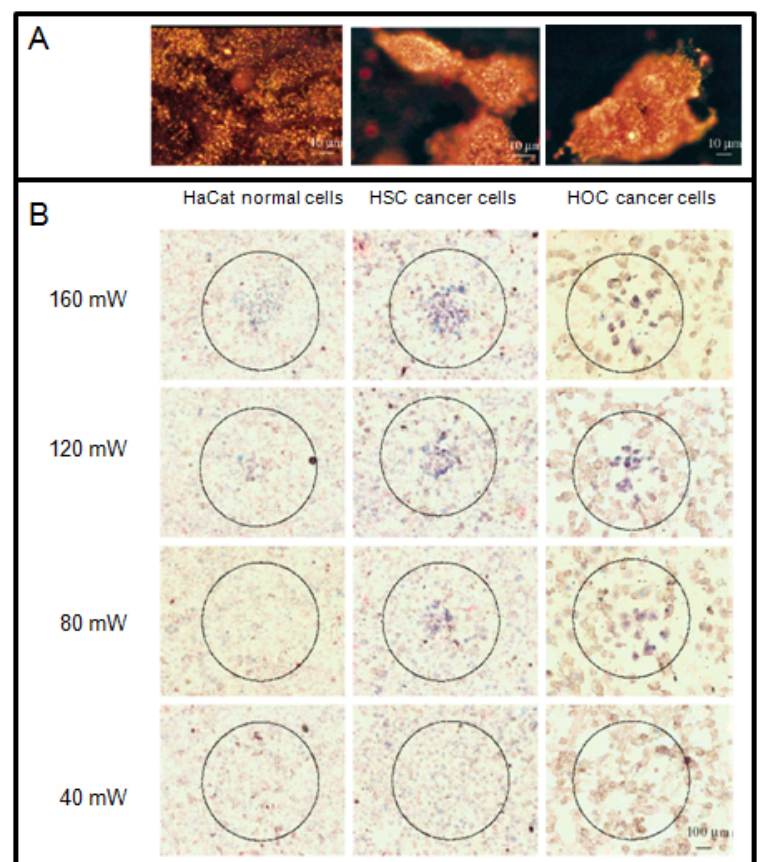
Figure 7. Gold nanorods (GNRs) for PTT. ( A ) Light scattering images of anti- EGFR/GNRs after incubation with cells (HaCat normal cell, HSC and HOC cancer cells) for 30 min at room temperature. ( B ) Selective PTT of cancer cells with anti-EGFR/GNRs incubated. The circles show the laser spots on the samples. At 80 mW (10 W/cm 2 ), the HSC and HOC cancer cells are obviously injured while the HaCat normal cells are not affected. The HaCat normal cells start to be injured at 120 mW (15 W/cm 2 ) and are obviously injured at 160 mW (20 W/cm 2 ). Reproduced with permission